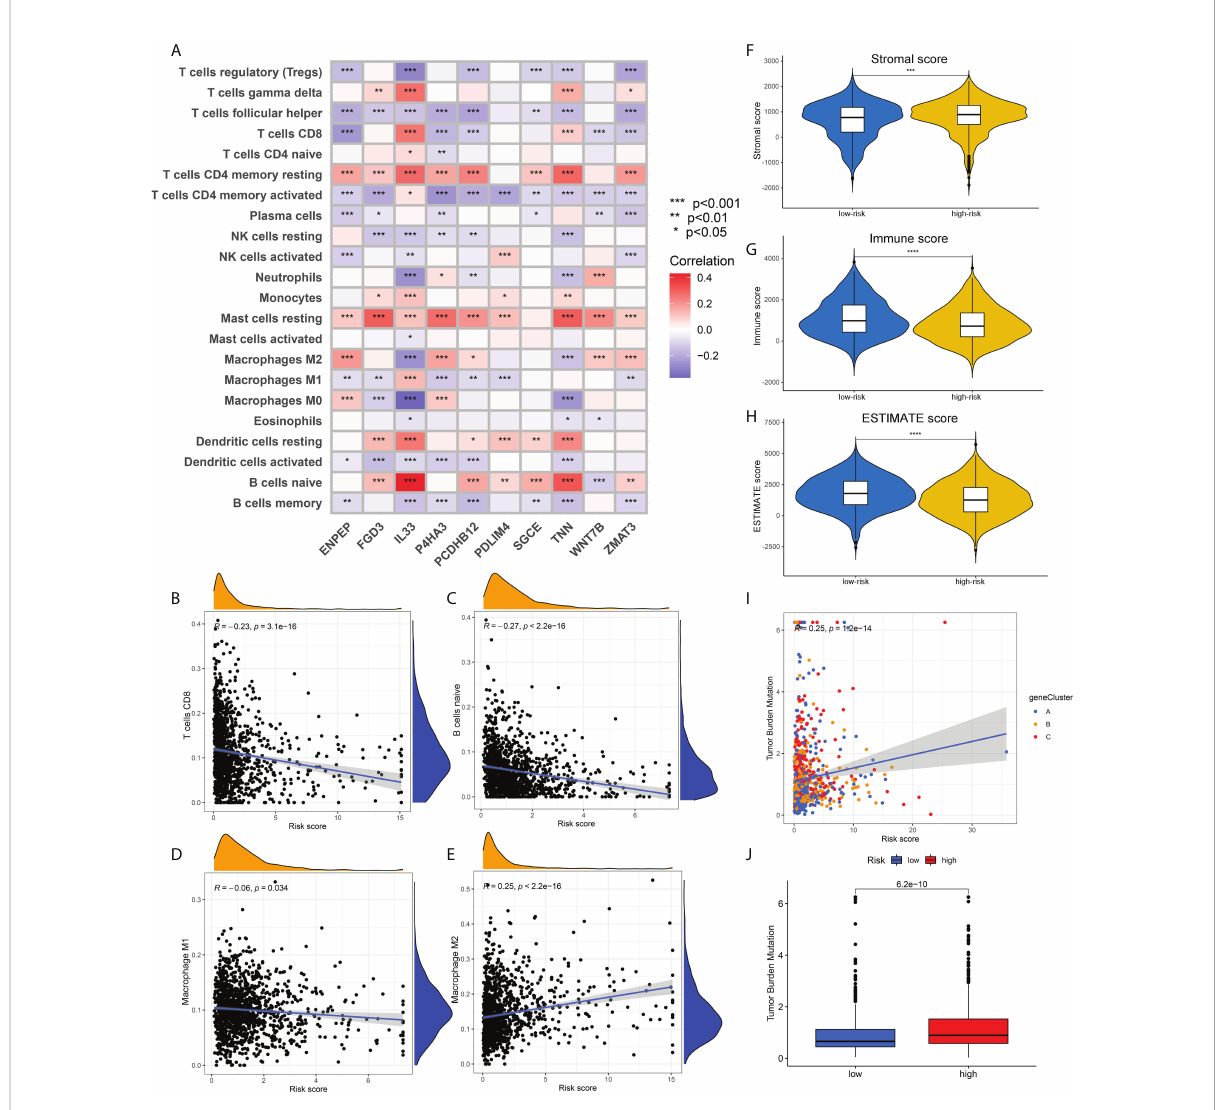
FIGURE 6 Association of risk scores obtained from the prognostic model with immune in fi ltration and TMB. (A) Heatmap showing the correlation between the relative abundance of 22 immune cells and 10 core prognostic genes of our prognostic model. (B-E) . Correlation analysis between risk scores and the contents of CD8+ T cells (B) , naïve B cells (C) , M1 macrophages (D) and M2 macrophages (E) . (F-H) . The distribution differences in stromal scores (F) , immune scores (G) and ESTIMATE scores (H) in breast cancer patients of different risk groups. (I) Correlation analysis between risk scores and TMB of breast cancer patients. (J) The distribution differences of TMB in breast cancer patients from different risk groups. TMB, tumor mutation burden; * p <0.05; ** p <0.01; *** p <0.001; **** p